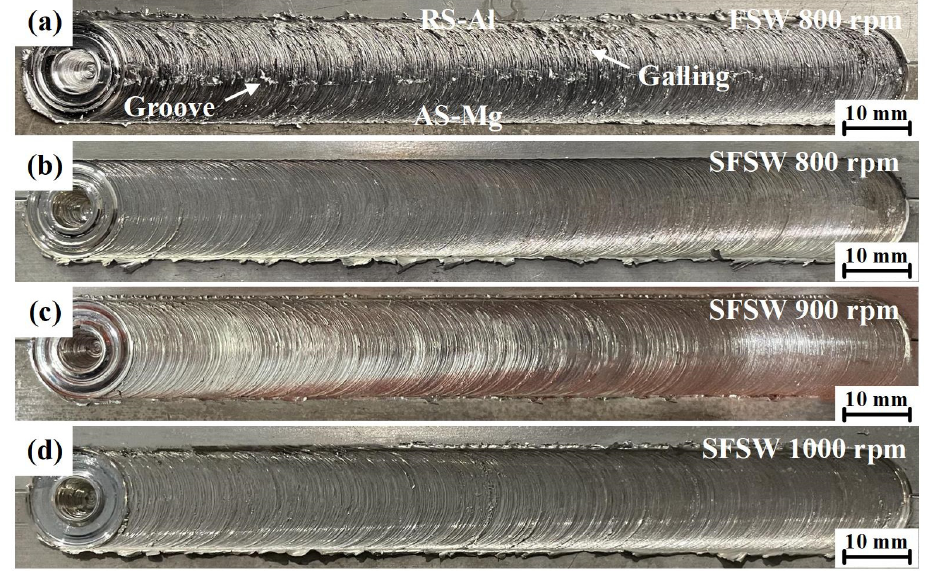
Figure 3. Surface morphologies of AA6061 Al/AZ31B Mg dissimilar joints produced by ( a ) FSW at 800 rpm, ( b – d ) SFSW at 800 rpm, 900 rpm and 1000 rpm.